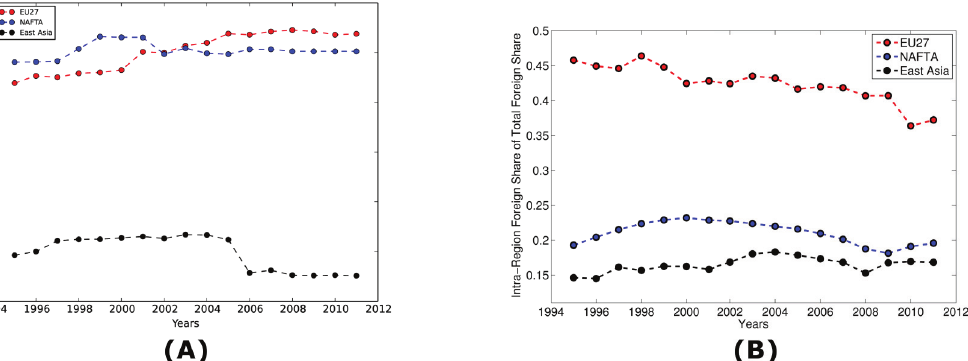
Fig 11. Regional clustering coefficient and intra-region foreign share of the foreign intermediate transactions over time. Panel (A) shows the average weighted clustering coefficient over time for three regions, EU27 (i.e., “ Euro-Zone ” and “ Non-Euro EU ” in S1 Table), NAFTA (see S1 Table), and East Asia (see S1 Table). EU27 and NAFTA have higher coefficients than East Asia and EU27 has an increasing trend over time, which coincides with the detection of the growing European community led by Germany. Panel (B) considers the intra-region foreign share out of the total foreign intermediate transactions for the same three regions. EU27 relies on the intra-region foreign trade the most and East Asia the least. Moreover, while the intra-region share in the other two regions is roughly stable, it has a clear decreasing trend in